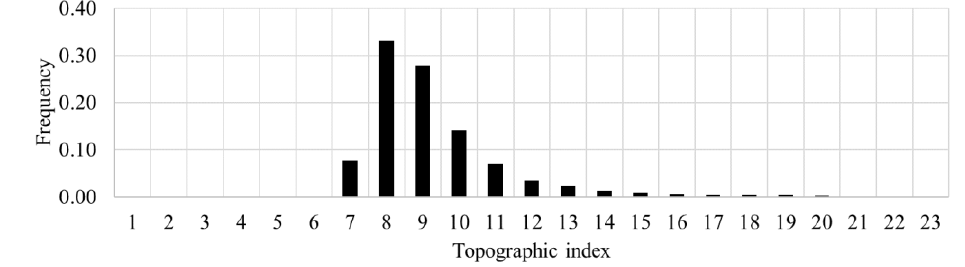
Figure 3. A histogram of the TI distribution of Atari River catchment. TOPMODEL tracks the water balance in the root zone, the saturated zone and the unsaturated zone. The model was calibrated to find the values of 5 unknown parameters, i.e.,: exponential decay parameter ( m ); downslope saturated transmissivity ( T e ); delay time constant ( t d ); maximum root zone storage deficit ( SRZ max ) and the initial root zone storage deficit ( SRZ initial ).